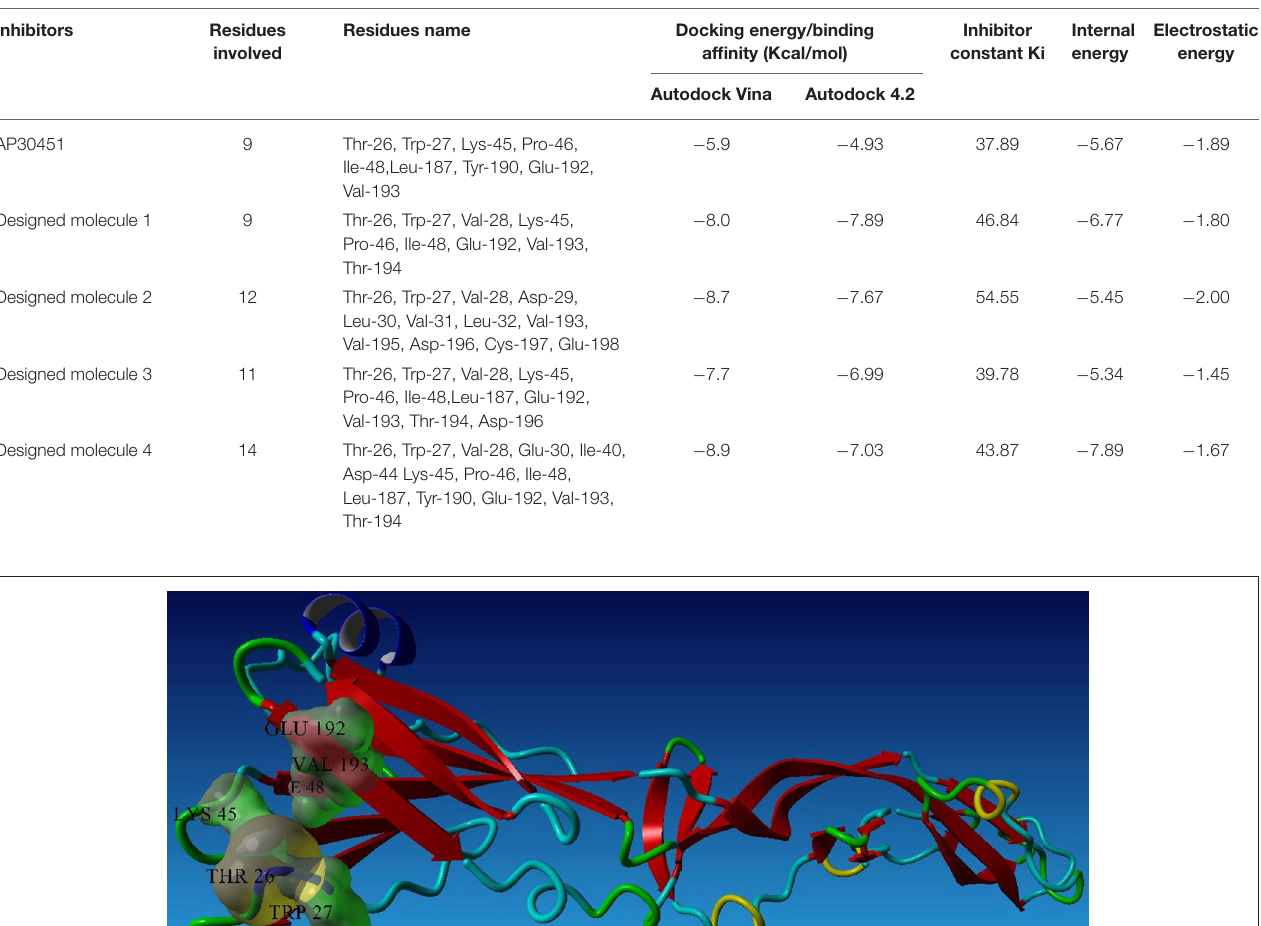
Table 3 and Figure 9 . Importantly, the interacting amino acid residues Figure 10 . The most common interacting amino acid residues were found viz Thr 26, Trp 27, and Val 193 from control and all the inhibitor molecules Table 4 and